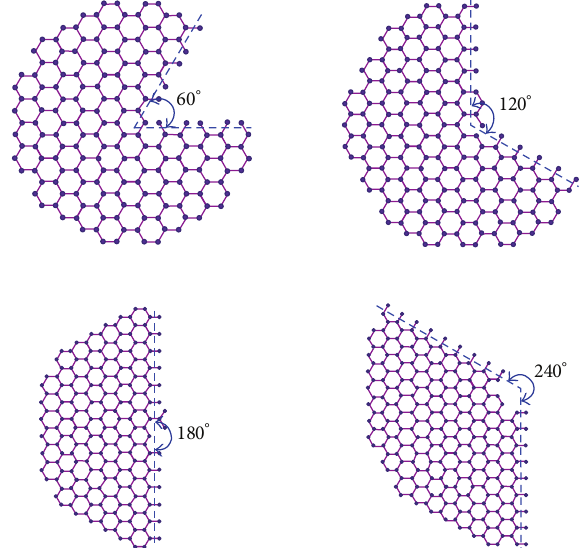
Figure 1: Cone sheets with disclination angles of 60 ∘ , 120 ∘ , 160 ∘ , and 240 ∘